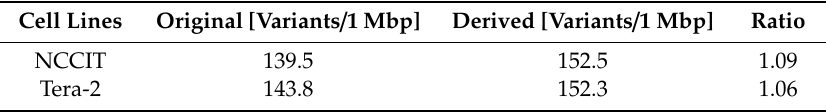
Table 2. Tumor mutation burden in TGCT cell